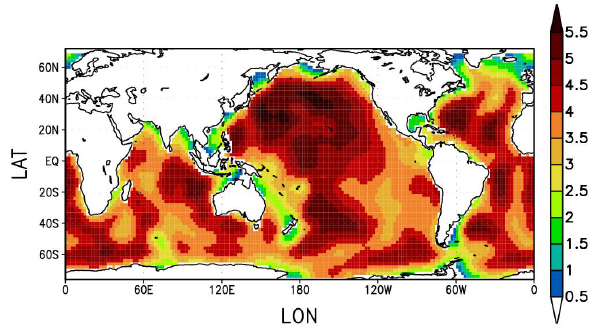
Fig. 2. Bottom topography of the oceans with 2 ◦ × 2 ◦ longitude and latitude resolution and realistic coast lines (black contour). Zero bottom isohyps is omitted. Contour (colour) interval is